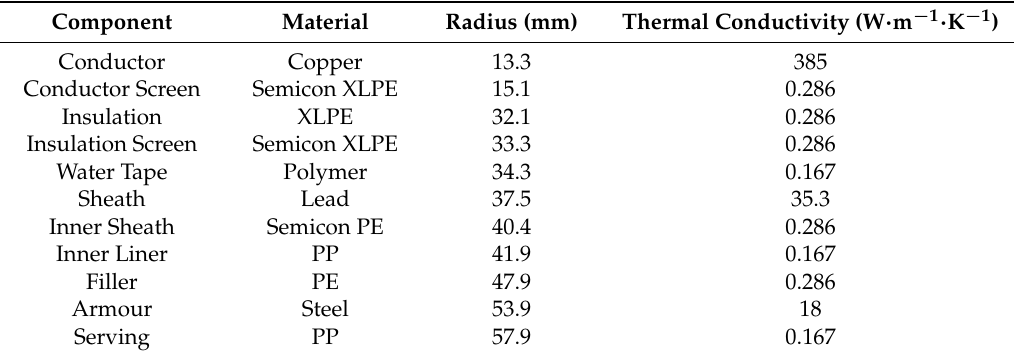
Table 1. Design parameters of the considered submarine